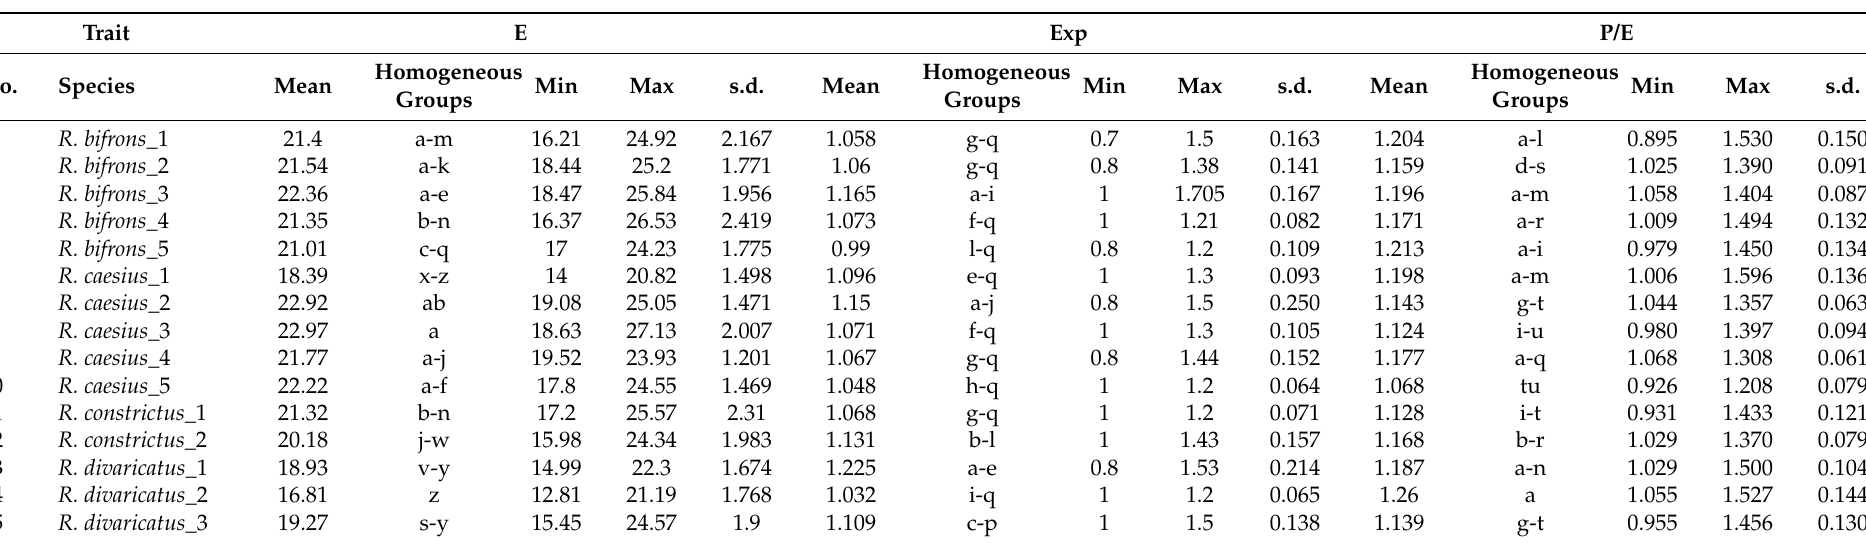
Table 4. Mean, minimal and maximal values as well as standard deviations (s.d.) for equatorial diameter (E), exine thickness along the polar axis (Exp) and